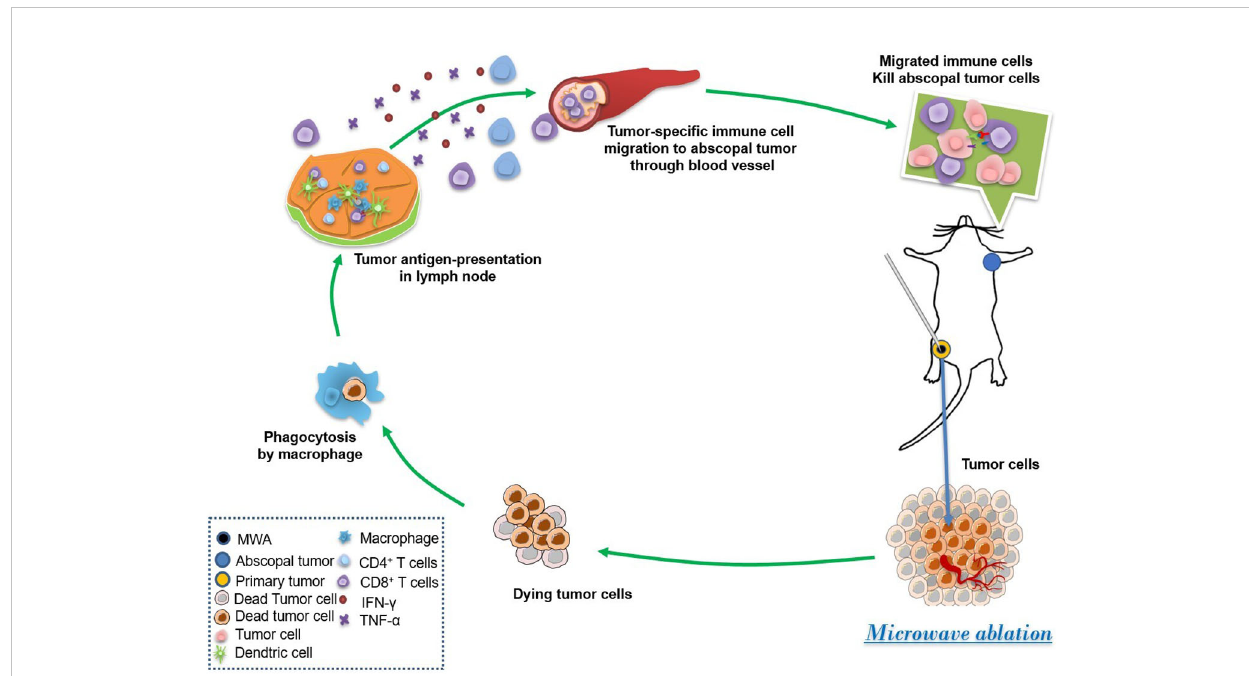
FIGURE 6 MWA induced the abscopal effect by the enhancement of systemic and local antitumor immunity. MWA begins the fi rst step of the immune cycle by killing tumor cells and releasing tumor antigens. Then, dead tumor cells were phagocytosed by macrophages, and tumor antigen is shown by antigenic presenting cells such as DCs. Afterward, the tumor-speci fi c immune cells are stimulated and migrated to the abscopal tumor through the blood vessel, fi nally suppressing the growth of the abscopal